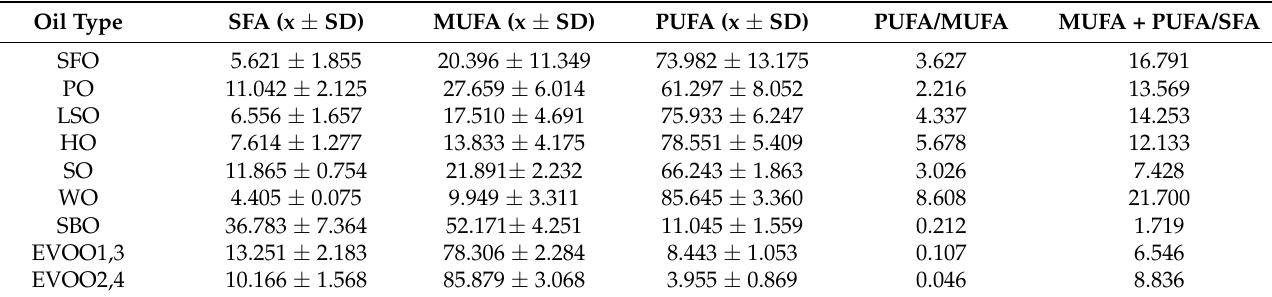
C18:1n-9 (Figure 1b). The HO and LSO oils contained distinctly C18:3n-3 at